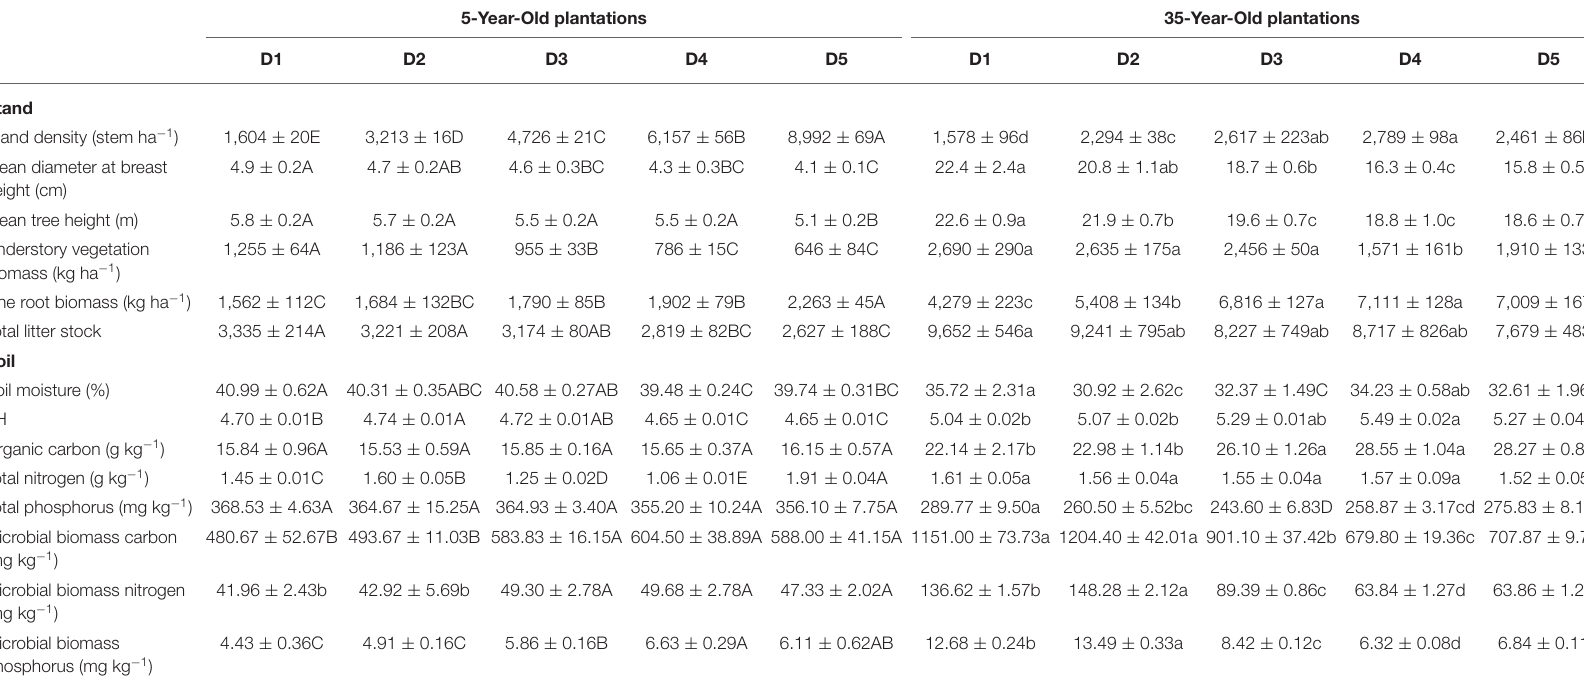
The data are shown as the means ± standard deviations (n = 3). Different uppercase and lowercase letters represent significant differences between planting densities at age 5 and 35, respectively. D1, 1,667 stems ha − 1 ; D2, 3,333 stems ha − 1 ; D3, 5,000 stems ha − 1 ; D4, 6,667 stems ha − 1 ; D5, 10,000 stems ha − 1